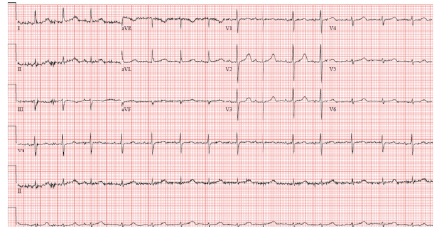
Figure 3: ECG after normalization of patient’s magnesium level showing normal sinus